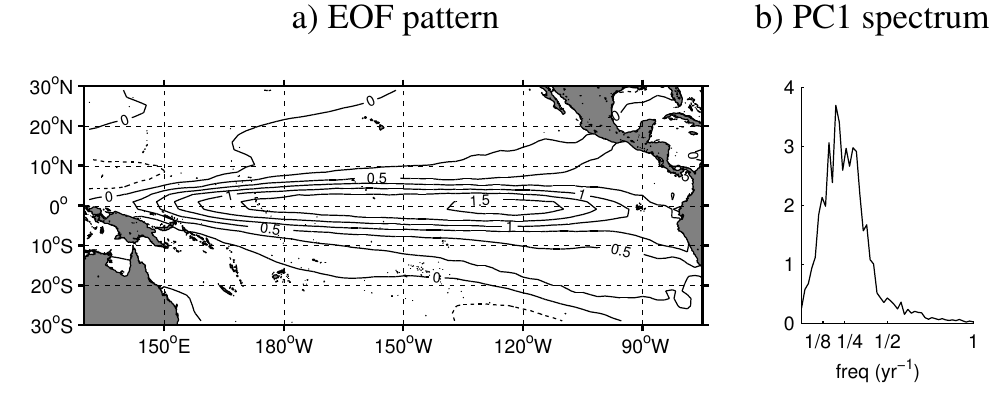
Fig. 1. (a) The first EOF of the SST anomalies in the equatorial Pacific. (b) Power spectrum of the first principle component (PC1), which is normalized to have unit variance. Table 1. Statistical moments of the NINO3 and NINO4 indices from the ESSENCE ensemble simulation and the HadiSST (Rayner et al., 2003) and Reynolds and Smith (1994) SST data analysis; N is the number of data